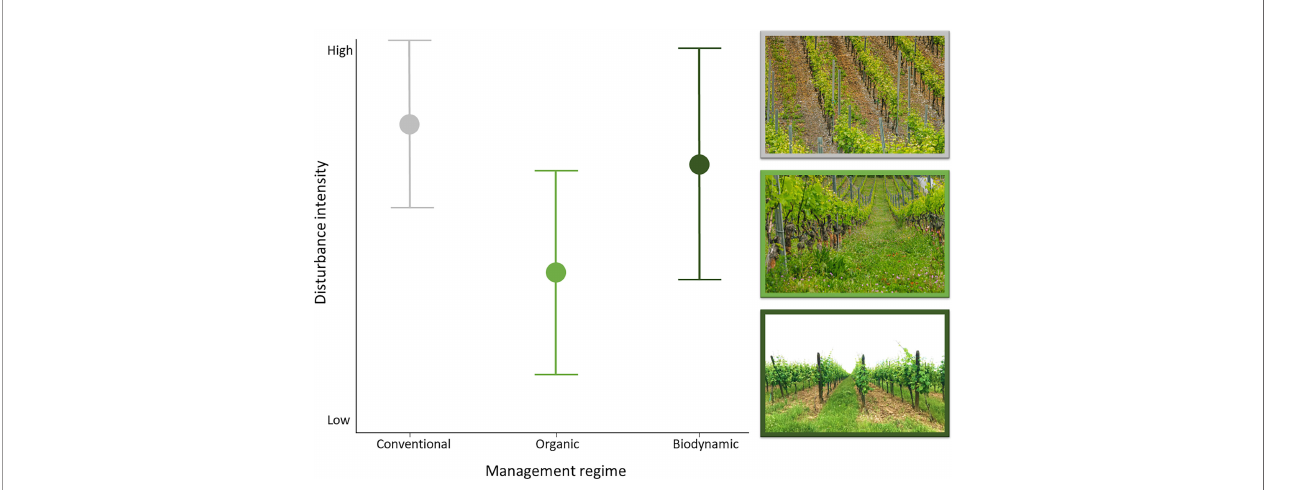
FIGURE 1 | Schematic representation of hypothesized soil and ground vegetation disturbance levels dependent on the management regime (i.e., conventional in grey; organic in green; biodynamic in dark green) and example pictures for the three management modes. Top: a high amount of bare ground due to herbicide applications characterizes conventional vineyards. Middle: organic vineyards are characterized by a structurally complex, and plant species diverse ground vegetation layer, in this case covering 100% of the surface. Bottom: an extreme case of biodynamic management, where every other inter-row was recently ploughed. ("(C) C.